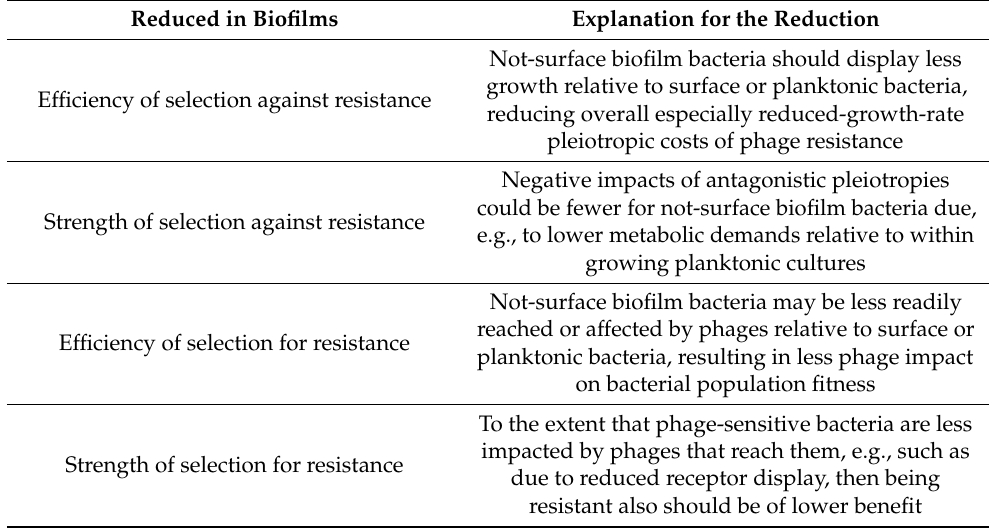
Table 1. Reduced strength and efficiency of selection for and against resistance within biofilms